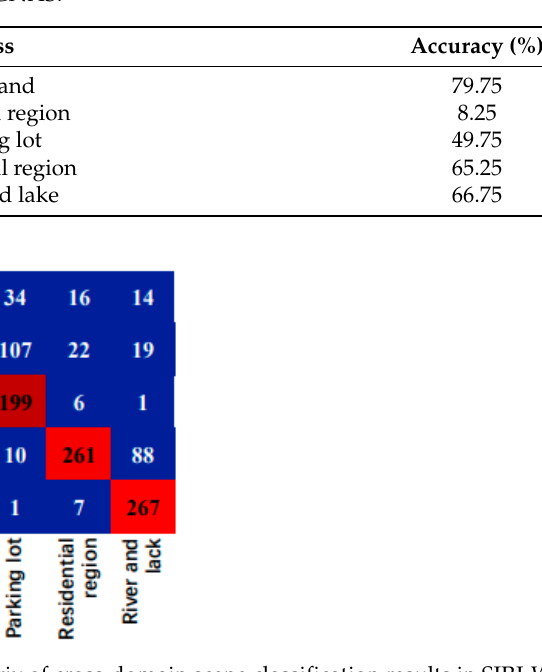
Figure 11. Confusion matrix of cross-domain scene classification results in SIRI-WHU → RSSCN7.